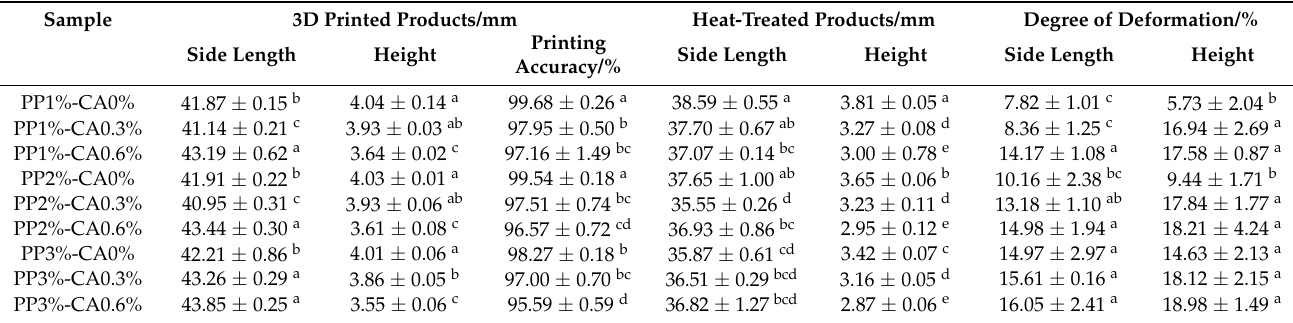
Table 3. Printing accuracy of restructured mackerel